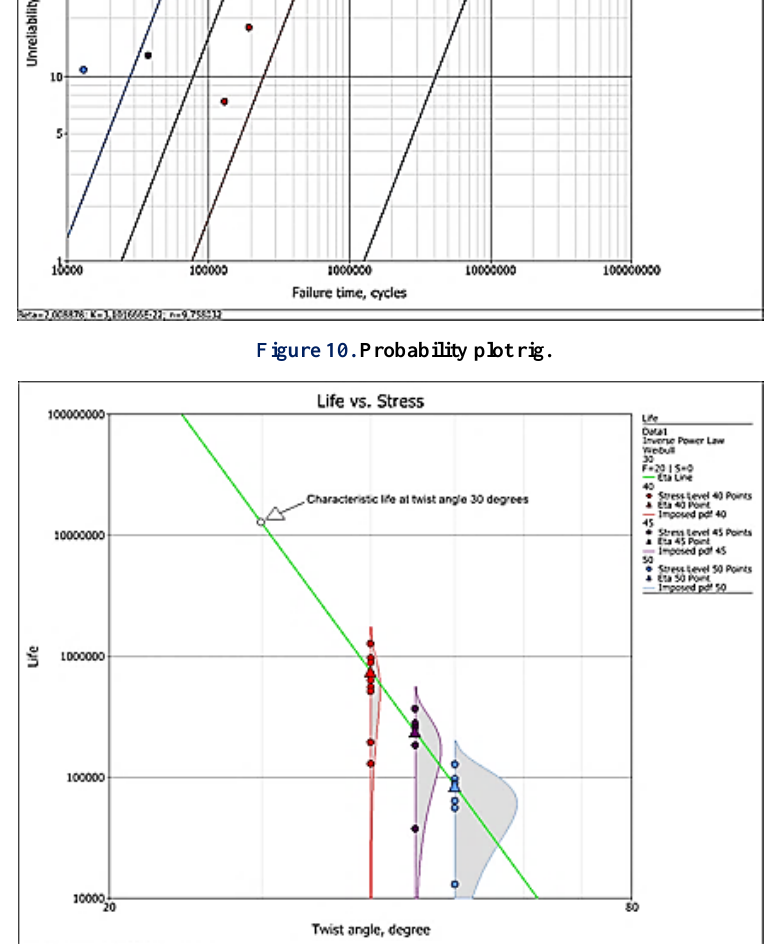
Figure 11. Life vs. stress